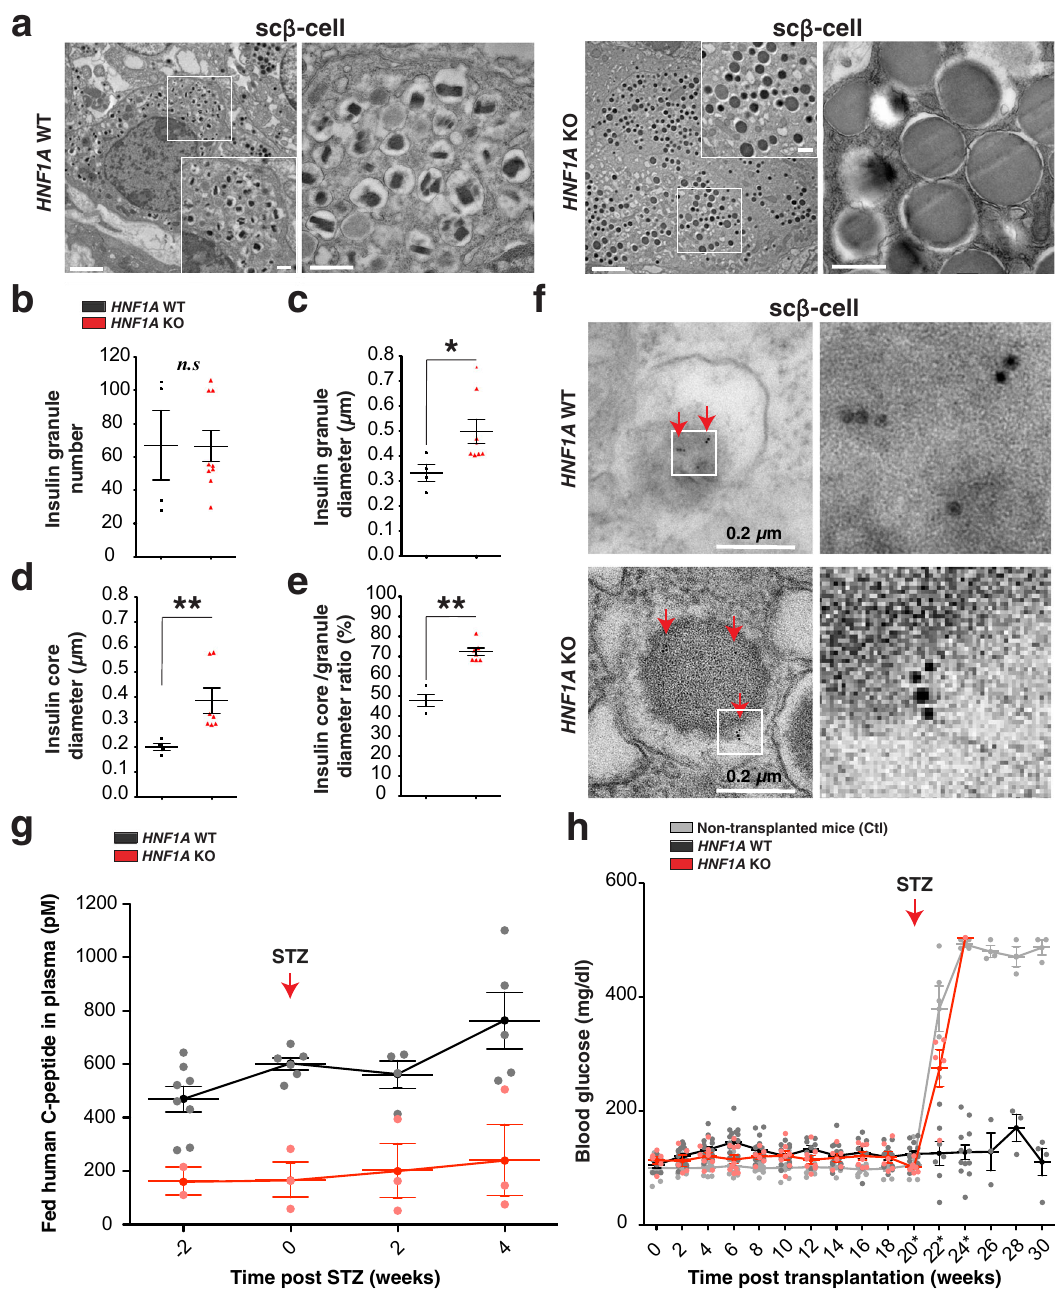
Fig. 5 HNF1A de fi ciency causes abnormal insulin granule structure and fails to maintain glucose homeostasis in diabetic mice. a – f Electron microscopy (EMC) analysis of isolated grafts 30 weeks post-transplantation for hESC-derived endocrine cells ( HNF1A WT and KO). Explants are from euglycemic mice. a Representative EMC images of sc β -cells with b quanti fi cation of insulin granule number, c insulin granule diameter ( µ m), d insulin granule core diameter ( µ m), and e insulin granule core diameter to insulin granule diameter ratio (%) per cell. Each point in the plot is the average of insulin granules per sc β -like-cells. Scale bars: 2 µ m in low and 0.5 µ m in high magni fi cation. f Representative EMC images of sc β -cells with human C-peptide immunogold labeling. Scale bar: 0.2 µ m. g Fed human C-peptide (pM) in plasma of ad libitum - fed mice transplanted with hESC-derived endocrine cells ( HNF1A WT n = 8 and KO n = 3) measured weeks before ( − 2) and after STZ treatment (0, 2 and 4). h Blood glucose concentrations (mg/dl) in ad libitum - fed mice transplanted with hESC-derived endocrine cells ( HNF1A WT n = 18 and KO n = 10) or without cells (Ctl n = 14). Mice ( HNF1A WT n = 6, KO n = 3 and Ctl n = 5) were injected (red arrow) with streptozotocin (STZ). All mice were transplanted with hESC-derived endocrine cells at day 27 of differentiation, and grafts were isolated 30 weeks post-transplantation for ex vivo analysis. All protein concentrations were measured by ELISA. ( n ) represents the number of biological replicates. For scatter plots, each point in the plot represents an independent biological experiment ( n ). Data are represented as mean ± SEM. p -values: * p < 0.05, ** p < 0.01, *** p < 0.001; Mann – Whitney test. n.s. non-signi fi cant. See also Figs. S9 and